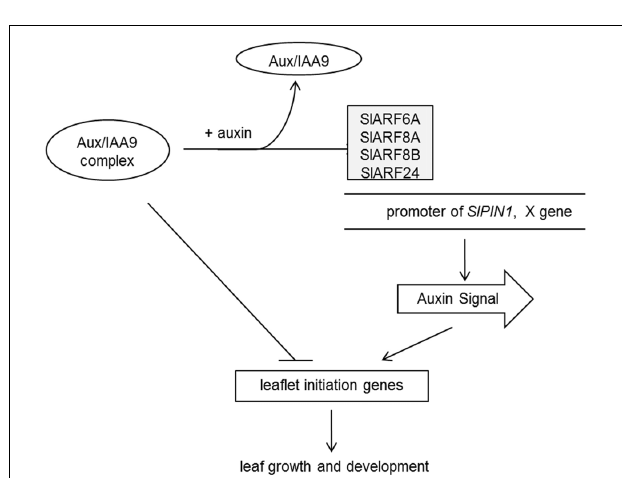
FIGURE 6 | A proposed model of SlIAA9 complex in the control of tomato leaf forms. SlIAA9 and SlARF6A, SlARF8A, SlARF8B, and SlARF24 proteins, form a regulatory complex, which can directly block leaflet initiation genes or act indirectly by preventing SlARFs from functioning as transcriptional activators. In the absence of SlIAA9, SlARFs may regulate leaf growth and development through direct binding to the promoter of SlPIN1 or other auxin-responsive genes, which promoted auxin